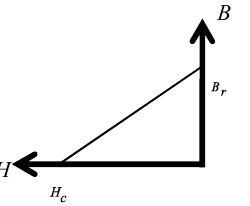
Figure 5. The curve for changes of flux according to the intensity of the permanent magnet field (reproduced with permission from [28]).